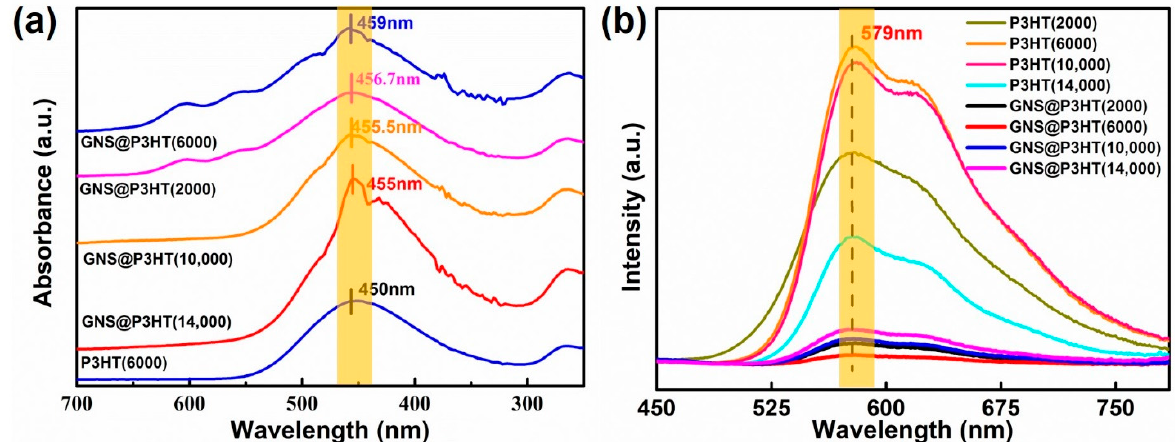
Figure 3. ( a ) Ultraviolet-visible (UV–Vis) absorption spectra of Graphene sheets @poly(3-hexylthiophene) (GNS@P3HT) with different molecular weights (0.001 g/mL). ( b ) Fluorescence spectra ( λ = 400 nm) of GNS@P3HT with different molecular weights (0.001 g/mL).